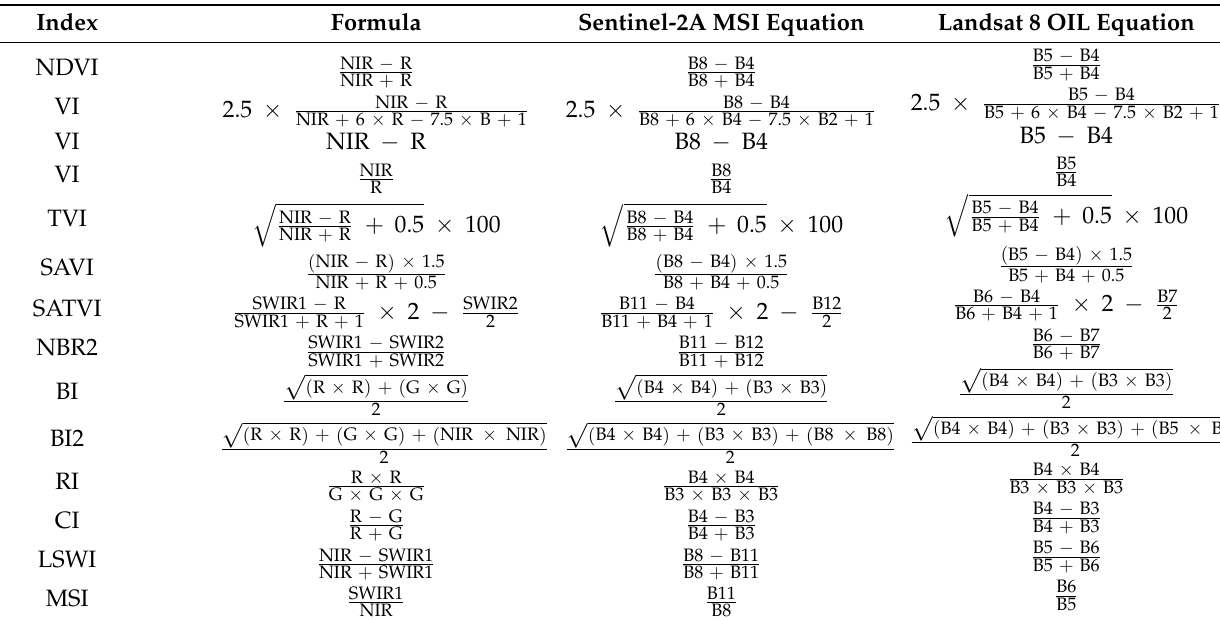
Table 3. Spectral index information for Landsat 8 and Sentinel-2A